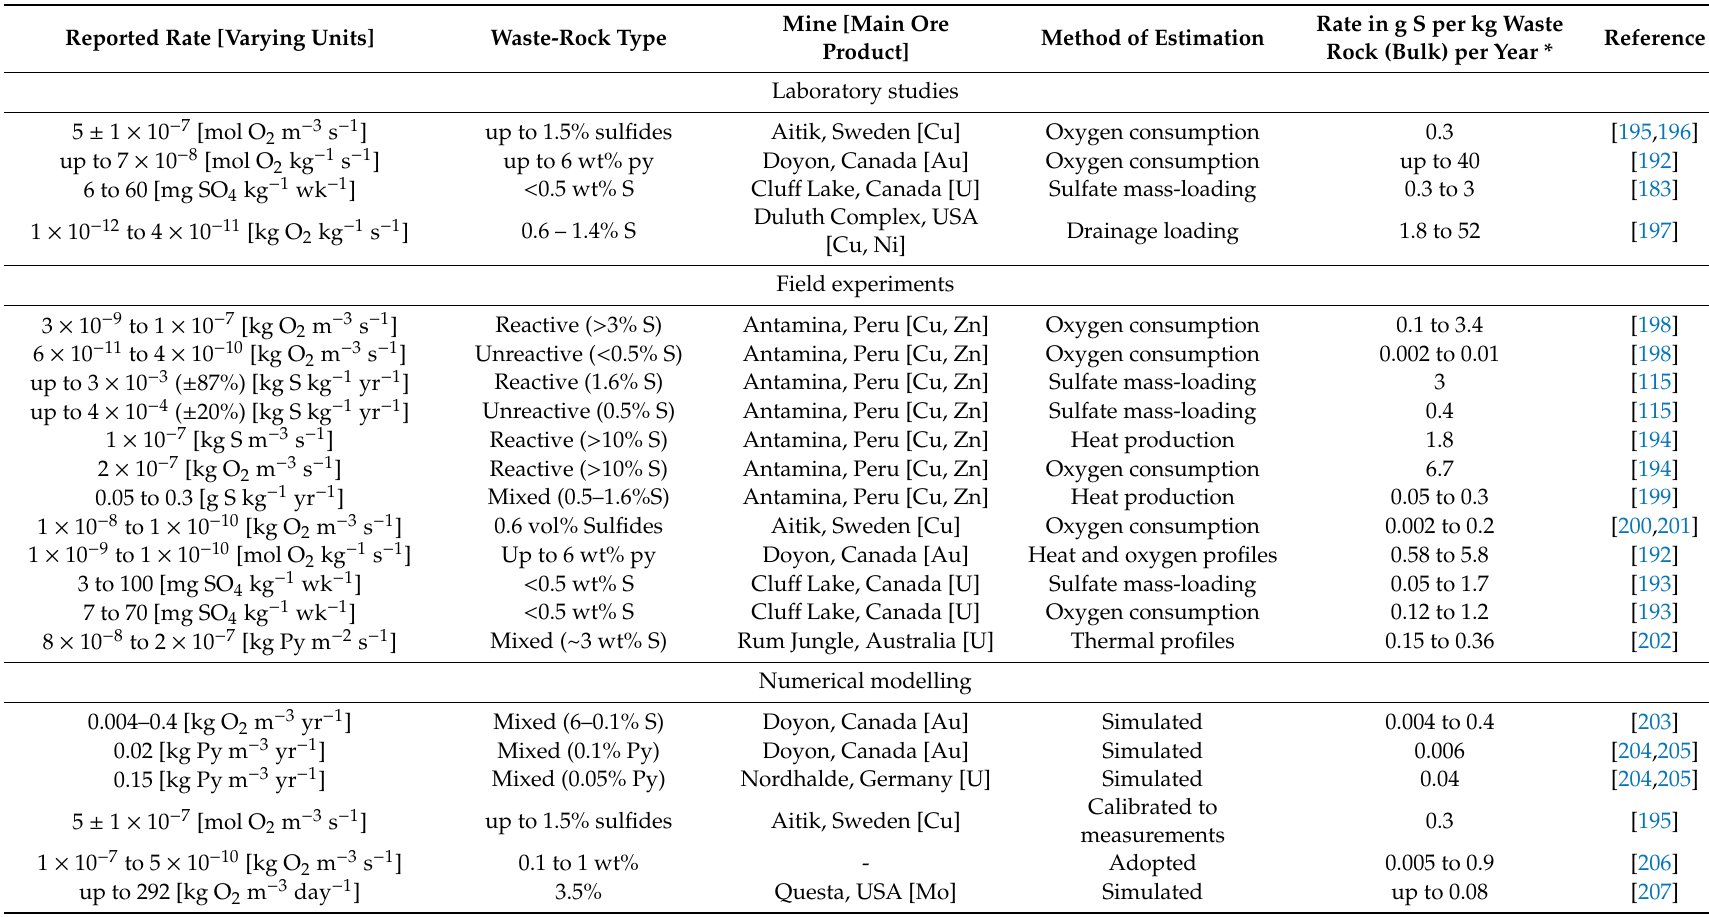
Table 3. Selection of waste-rock weathering rates reported for mine sites around the world, including field studies, laboratory experiments, and numerical